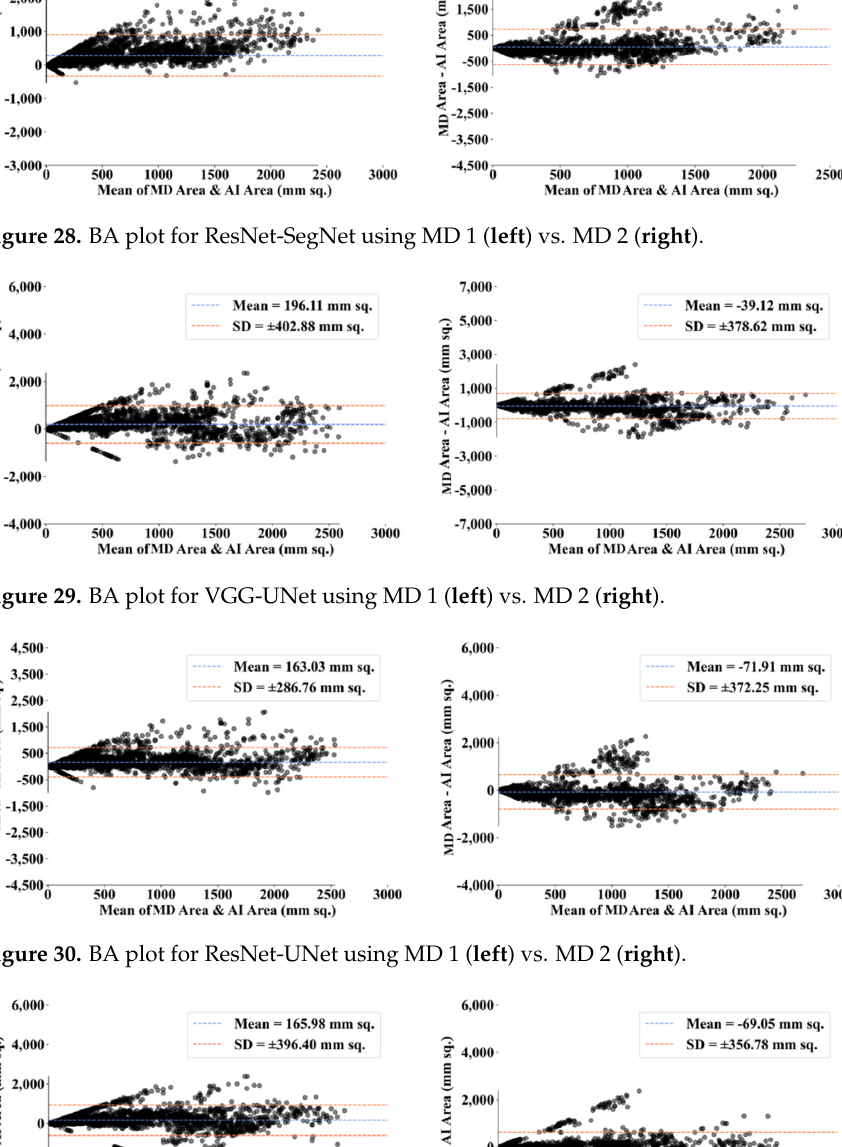
Figure 27. BA plot for VGG ‐ SegNet using MD 1 (left) vs. MD 2 (right).